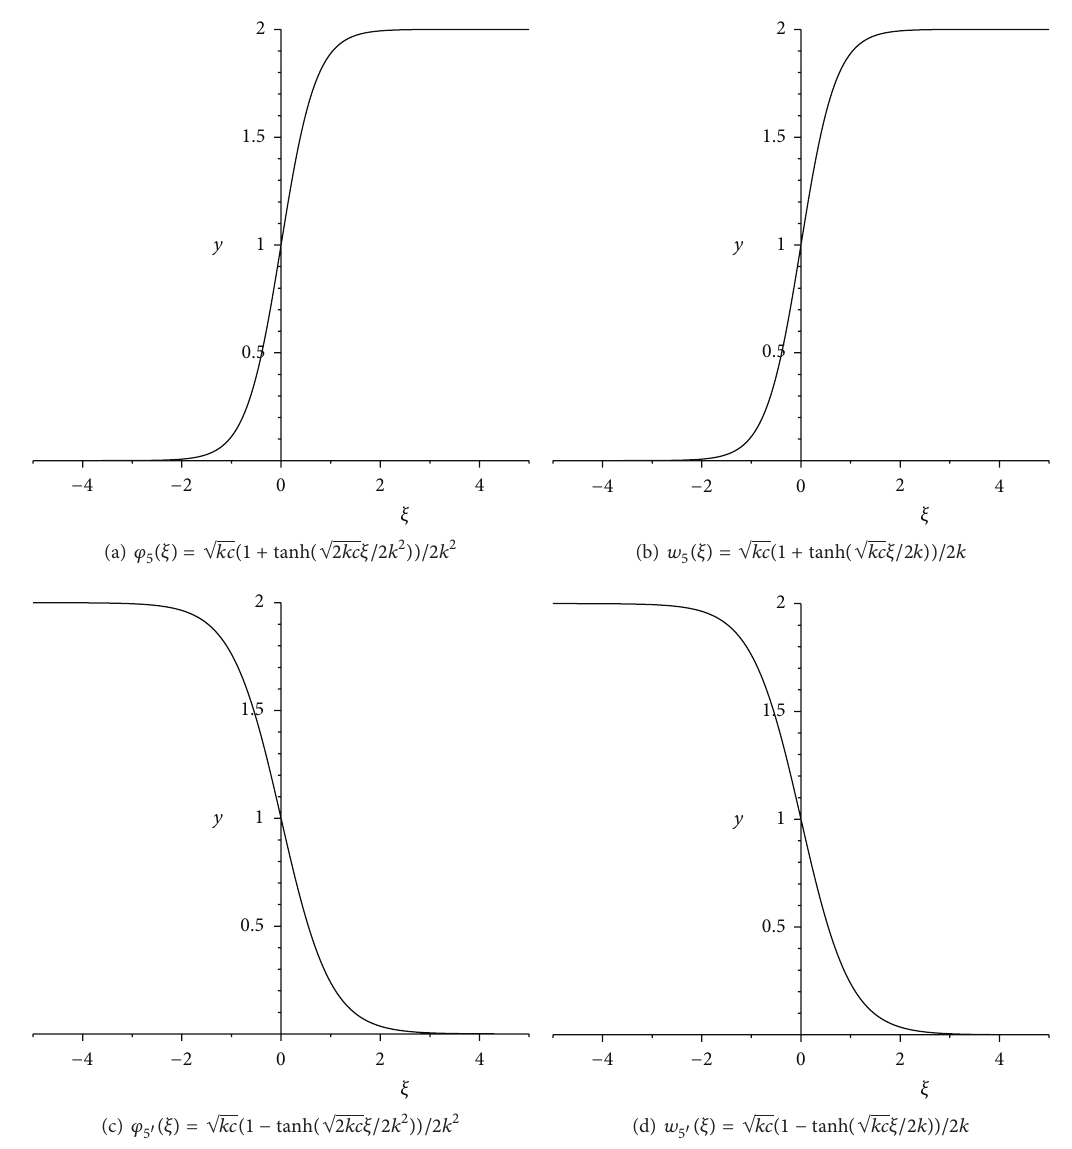
Figure 8: The kink (antikink) wave solutions of system (11) and (3) when 𝑟 = 2√𝑘𝑐 , 𝑘 > 0 , 𝑐 > 0 , and Δ ≥ 0 .